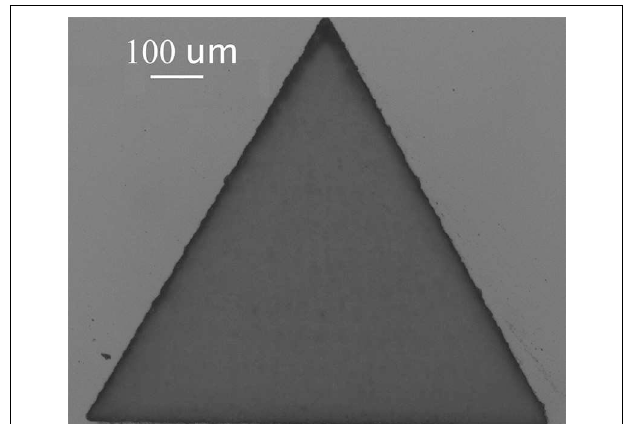
FIGURE 11 | Micro-milled pattern in fused silica using 6ps pulses (1030nm) delivered pulses via the NCF [50].